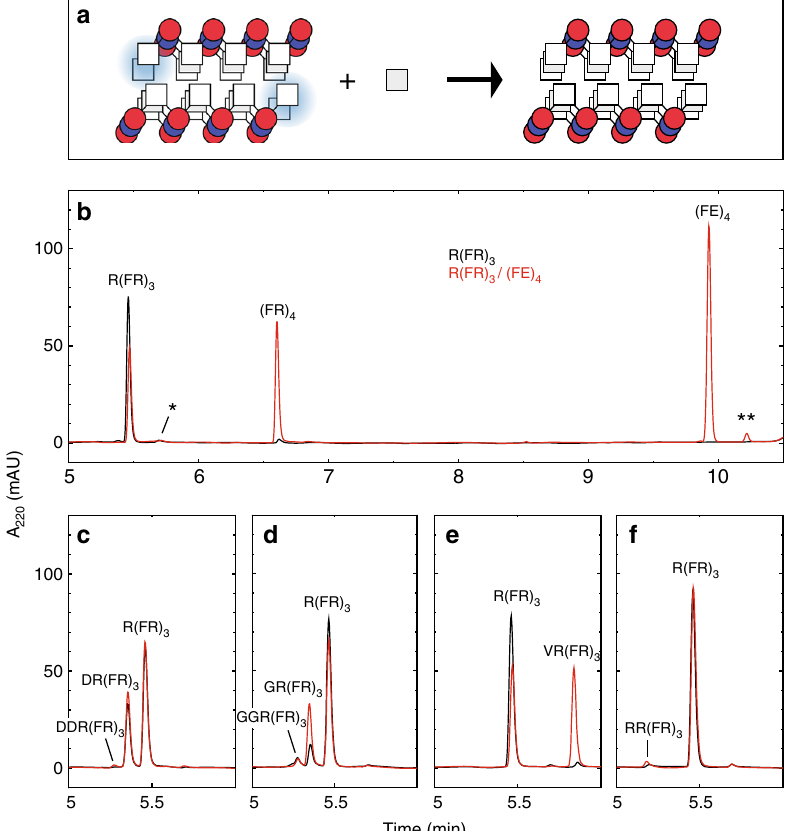
Fig. 1 Single addition reactions with the R(FR) 3 /(FE) 4 amyloid. a Schematic model of the amyloid-templated addition reaction, depicting just three layers of the repetitive amyloid structure in which the phenylalanine is represented by squares and the arginine and aspartate by blue and red circles respectively. The blue shading highlights the sites of addition in the substrate peptide. b – f , Reverse-phase HPLC chromatograms of the addition reactions with phenylalanine ( b ), aspartate ( c ), glycine ( d ), valine ( e ) and arginine ( f ). The * and ** indicate the C-terminal deamidated substrate and template, respectively, that remained after puri fi cation. The reactions with just the substrate R(FR) 3 are the black traces and those with the amyloid R(FR) 3 /(FE) 4 are the red ones. The R(FR) 3 concentration was 100 μ M, the (FE) 4 concentration was 130 μ M and amino acids were all at 100 μ